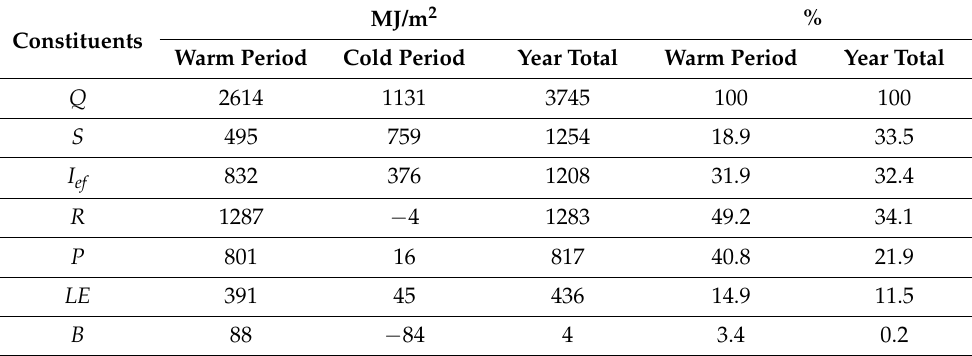
Table 1. Components of energy exchange between soil and atmosphere in the open area at